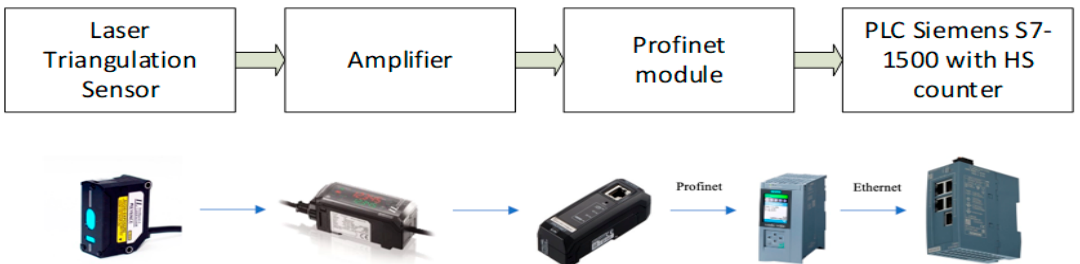
Figure 2. Measuring system LTS (Keyence—IL 100).